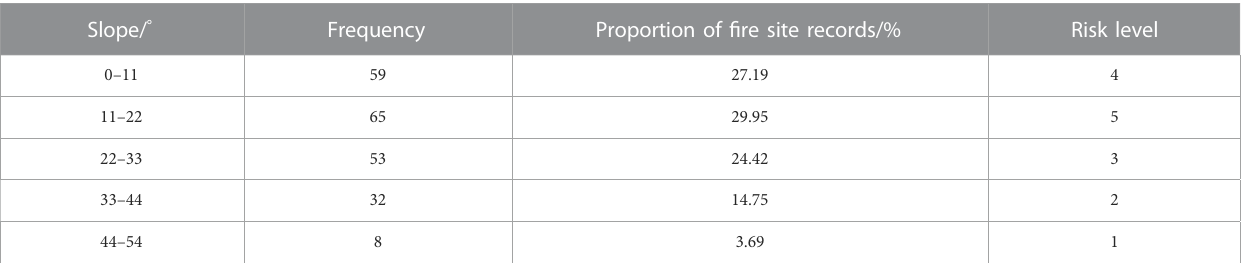
TABLE 3 Classi fi cations of